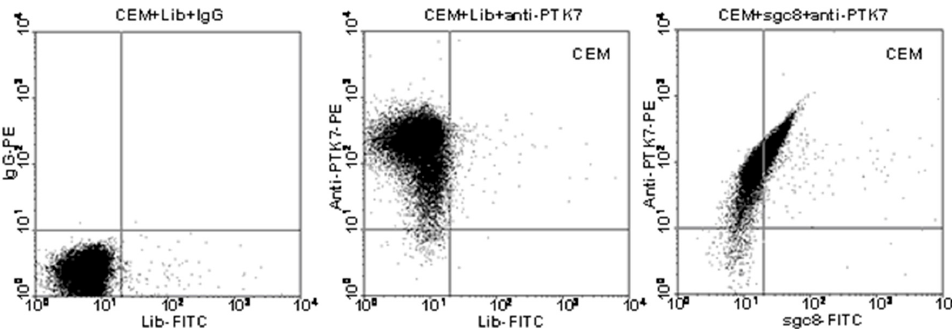
Figure 13. Flow cytometry analysis of CEM cells targeted with anti-PTK7-PE or sgc8-FITC. Reprinted with permission from © (2009) American Chemical Society [94]. Cancers 2018 , 10 , x